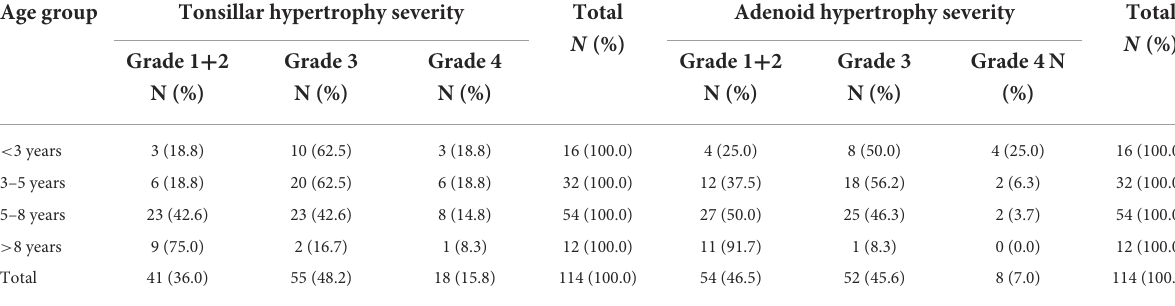
TABLE 1B The classification of tonsillar hypertrophy and adenoid hypertrophy by age